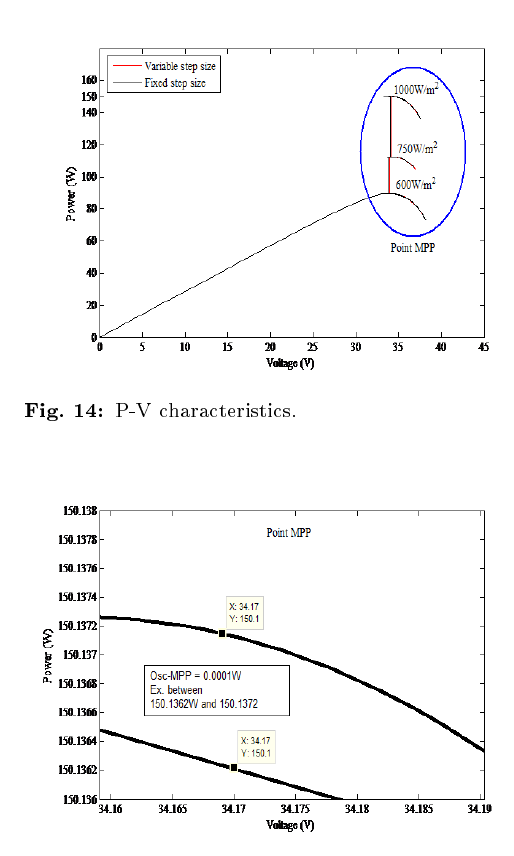
Fig. 15: P-V characteristics: Zoom in Point MPP (os- cillation in the case of the variable step size MPPT).